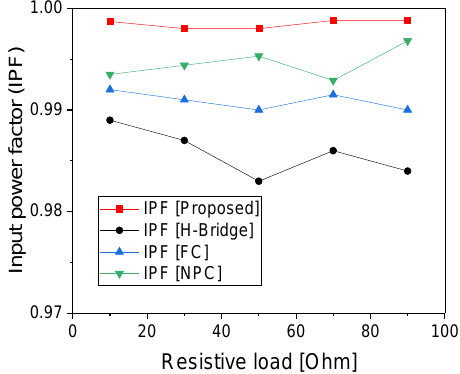
Figure 21. Comparison of THD vs. load with conventional rectifier.